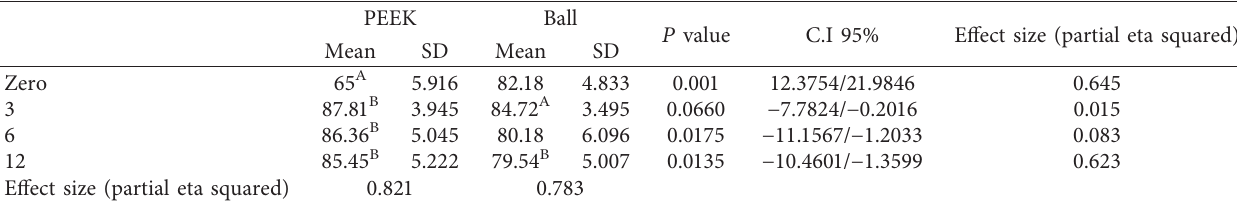
Table 2: Comparison between overall satisfaction in the two